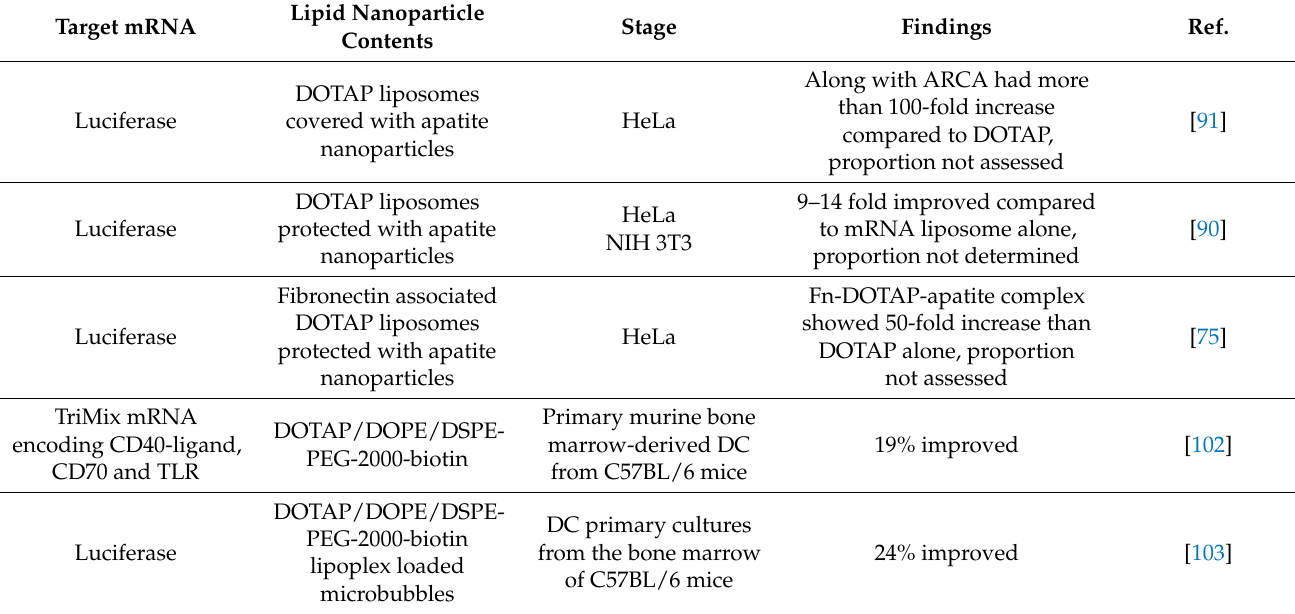
Table 2. LNPs-mRNA formulated